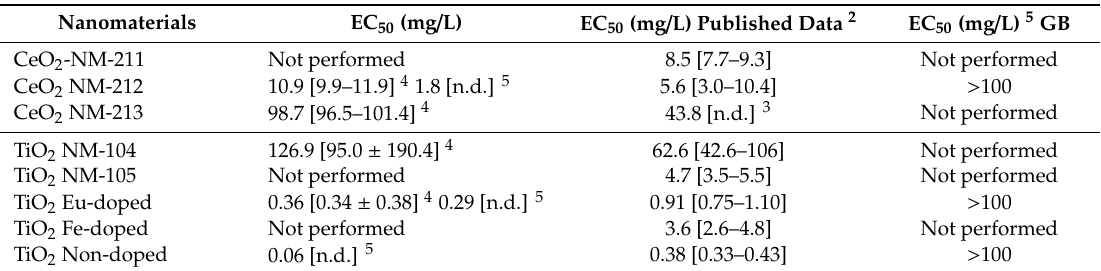
Table 4. EC 50 values determined in growth tests (OECD medium) with the green alga Raphidocelis subcapitata 1